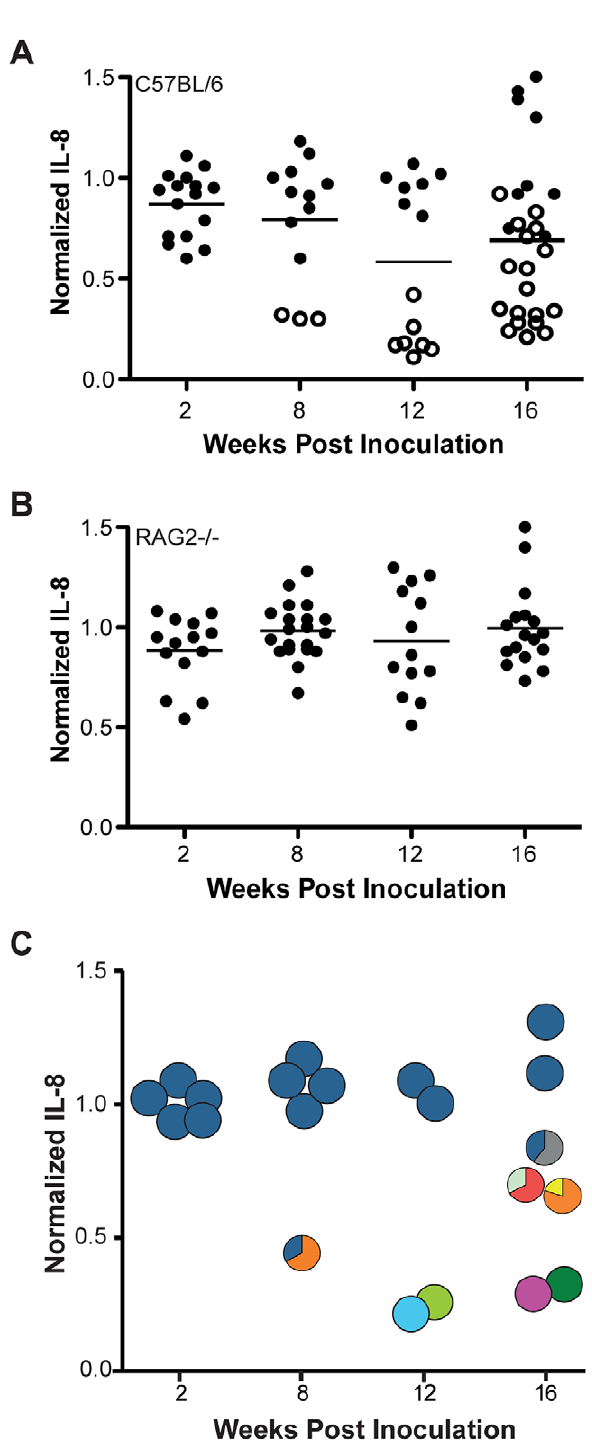
Figure 3. Loss of the capacity to induce IL-8 and change cagY during infection of mice is dependent on an intact host immune system. H. pylori was isolated from C57BL/6 WT (A) or RAG2 2 / 2 (B) mice (N=3–6/time point) up to 16 weeks after experimental infection with H. pylori WT J166. Individual colonies (3– 6/mouse) were co-cultured with AGS cells, and ELISA was used to measure IL-8 levels, which were normalized to the WT J166 positive control (line=mean). Each data point represents the results from a single colony. Induction of IL-8 in colonies isolated from WT mice was significantly lower than in RAG2 2 / 2 mice at 12 and 16 weeks PI